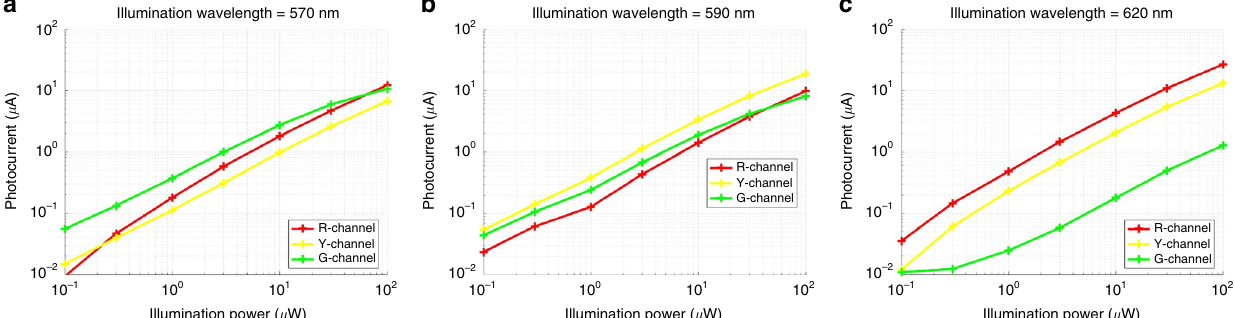
Fig. 5 Measured photocurrent as a function of illumination power. Measured photocurrent in green, yellow, and red color channels as a function of illumination power at illumination wavelengths of a 570 nm, b , 590 nm, and c 620 nm. Color-sorting behavior is consistently observed over three orders of magnitude of illumination power. Source data for a – c are provided in the Source Data File tabs labeled a – c ,